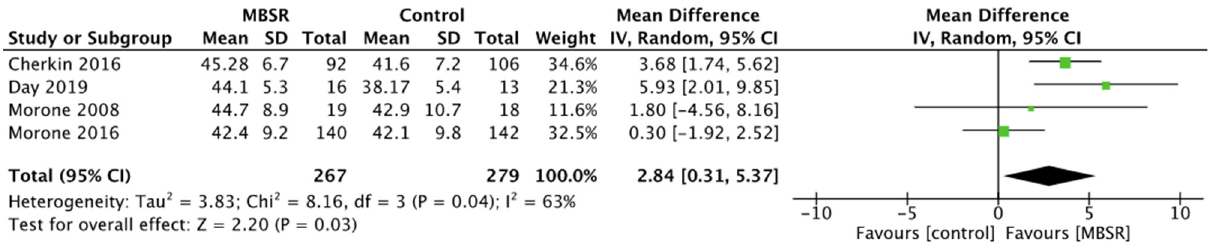
Figure 8. Quality of Life: MBSR versus control.